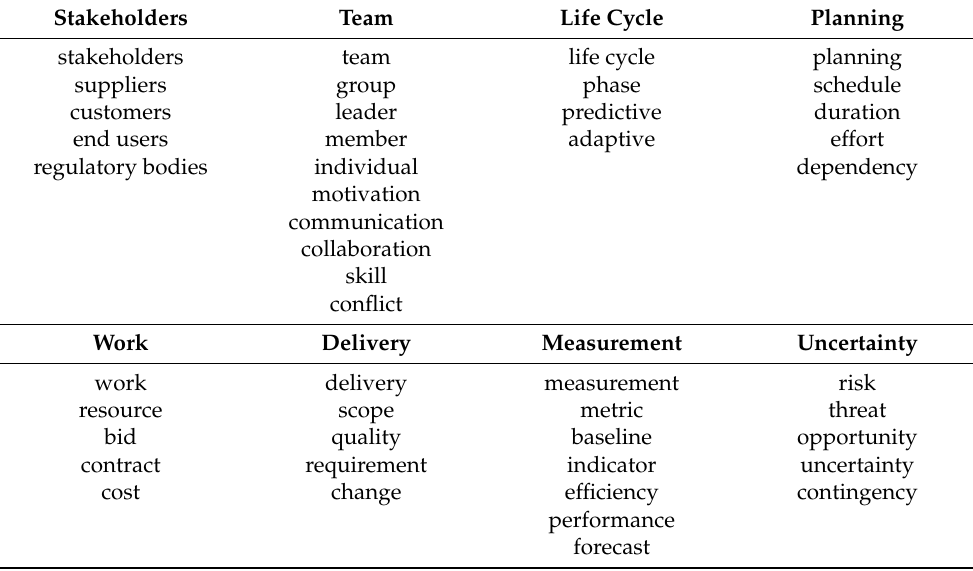
Table 1. Keywords for each project performance